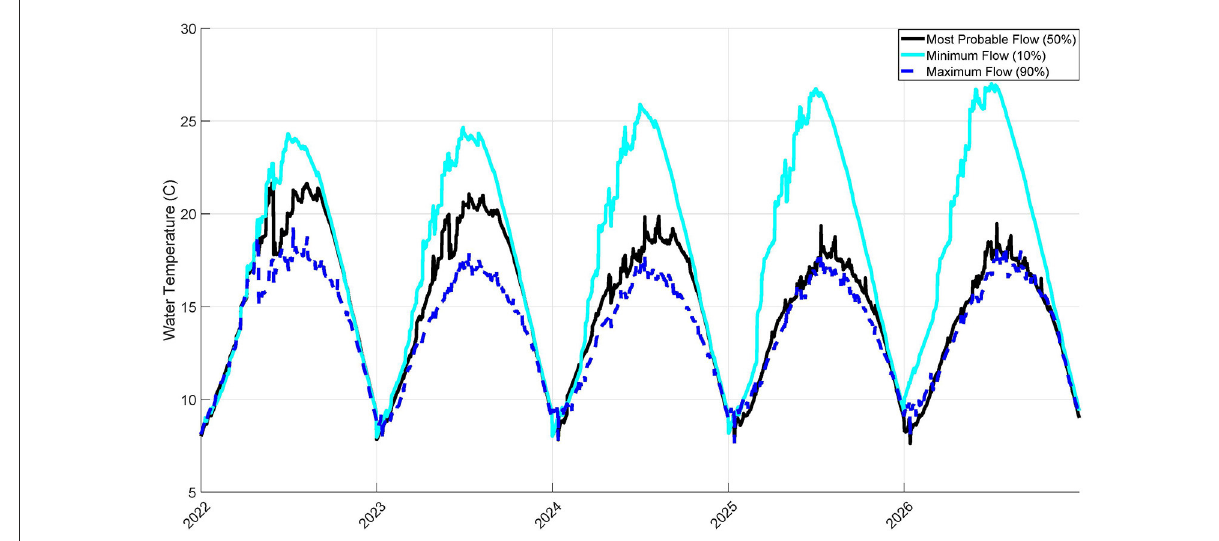
FIGURE6 Projected inflow temperature entering Lake Mead.